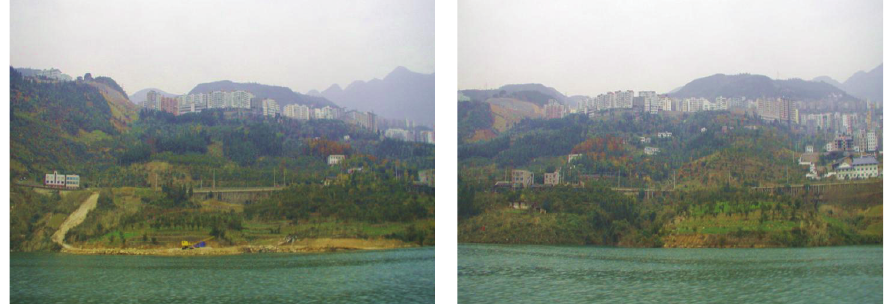
Figure 3: Zhaoshuling Landslide and the New Badong County.